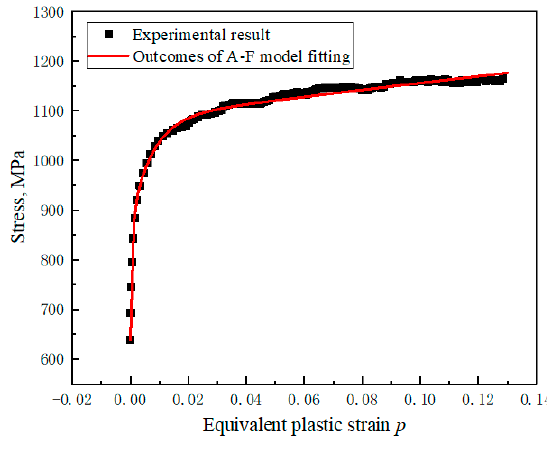
Figure 9. Outcomes of A-F model fitting.